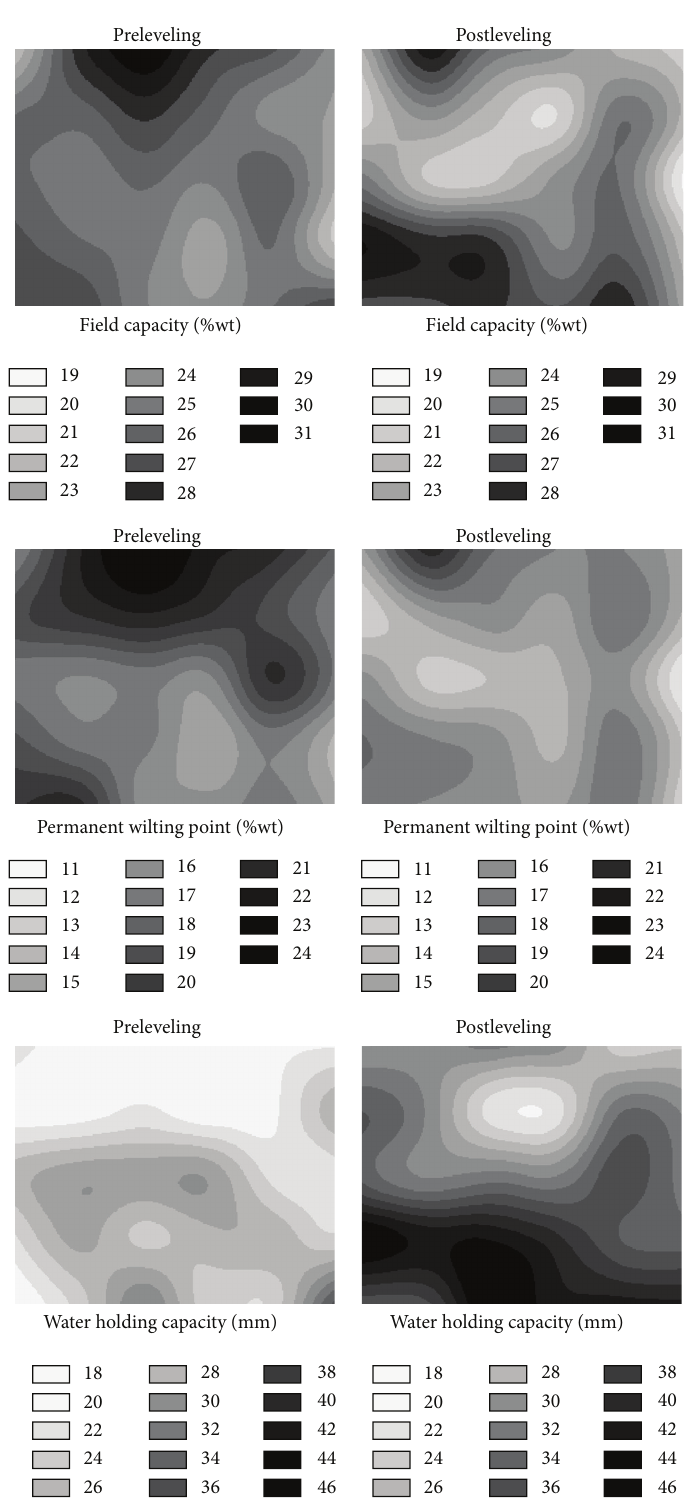
Figure 6: Pre- and post-leveling spatial distributions of soil field capacity, permanent wilting point, and water holding capacity for surface soil